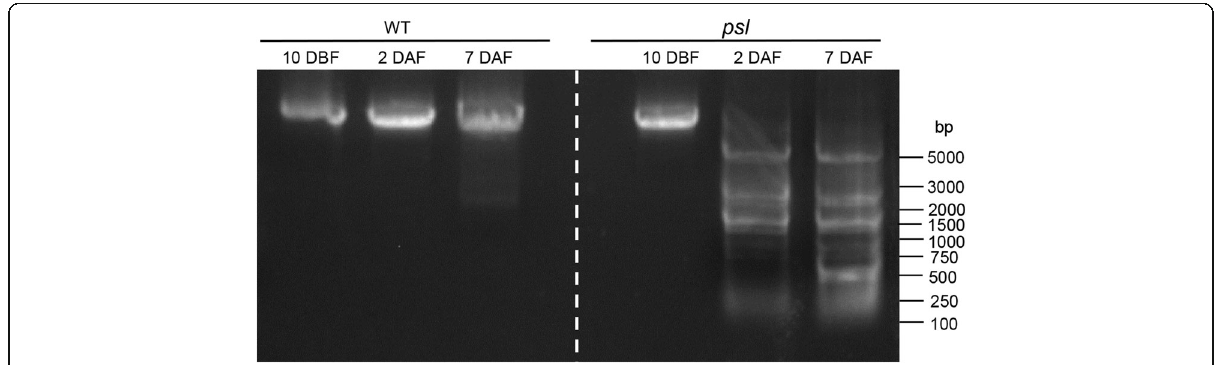
Fig. 3 DNA fragmentation in psl mutant. The DNA ladder of psl plants was detected by DNA gel blot analysis. Equal amounts of total DNA isolated from psl and wild-type plants at the same developmental stage were loaded in each lane. Positions of DNA standards (identified in bases) are indicated at right. 10 DBF: 10 days before flowering; 2, 7 DAF: 2 and 7 days after